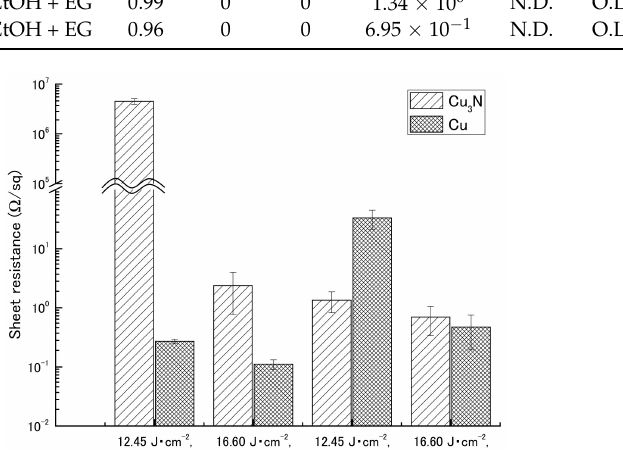
glycol (4.52 × 10 6 and 2.37 × 10 0 Ω sq − 1 at 12.45 and 16.60 J cm − 2 , respectively) than in the presence of ethylene glycol (1.34 × 10 0 and 6.95 × 10 − 1 Ω sq − 1 at 12.45 and 16.60 J cm − 2 , respectively).